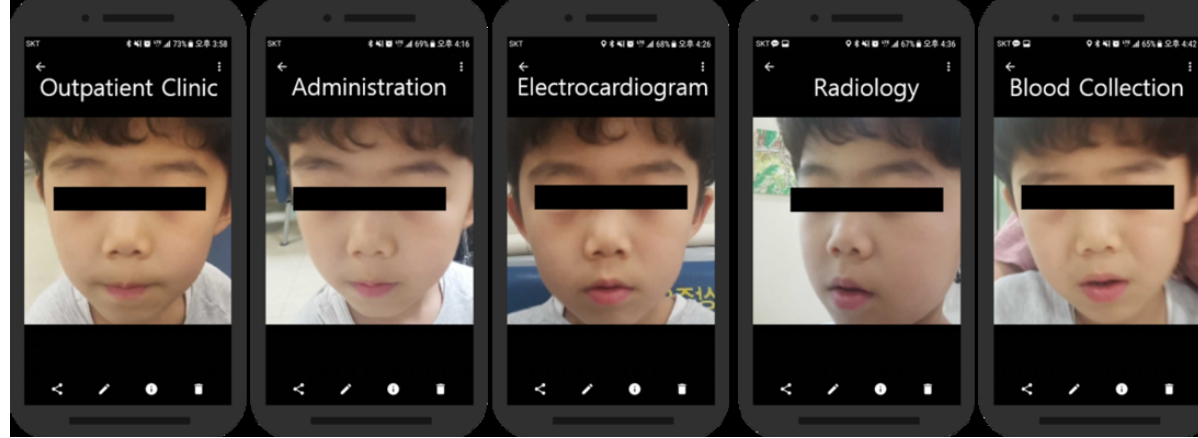
Fail verification, nPass verification, nCharacteristic